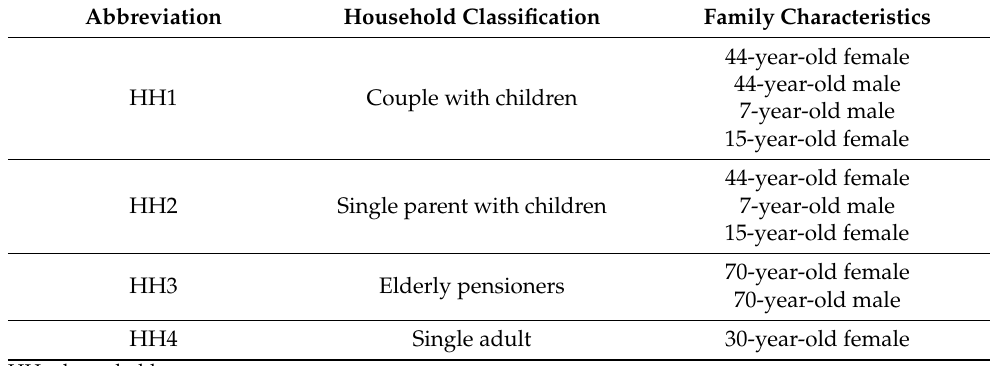
Table 1. Household and family characteristics used for the healthy food basket